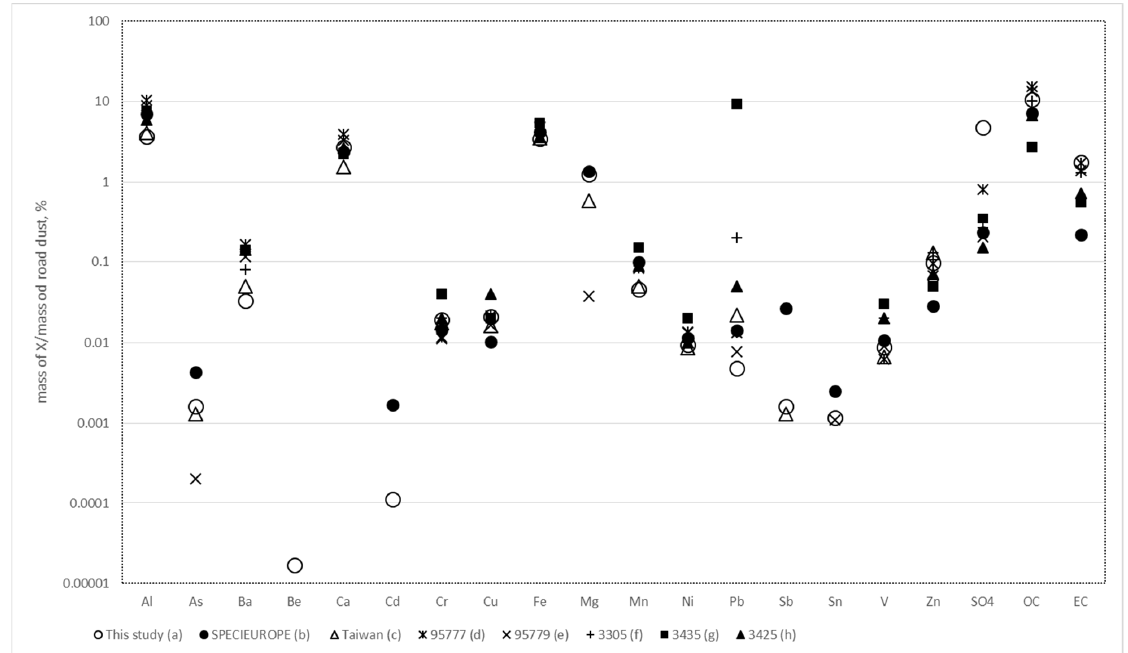
Figure 2. Road dust compositions (masses of elements to mass of road dust ratio, %). (a) Compositions of road dust were determined from the laboratory resuspension (TSP fraction). (b) SPECIEUROPE: Profile no. 12 (Road dust), (c) Wang et al. [30] (Freeway tunnel, SO 42 − was calculated from the reported sulfur concentration), (d) SPECIATE: Profile no. 95777 (Paved road dust, PM 10 ).